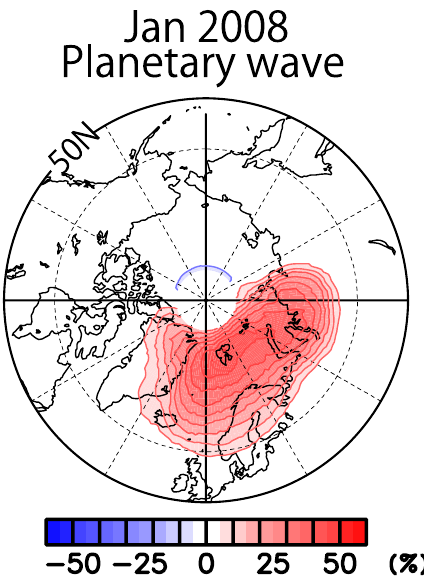
Fig. 17. The same as Fig. 13a but for January 2008 in the Northern Hemisphere at an altitude of